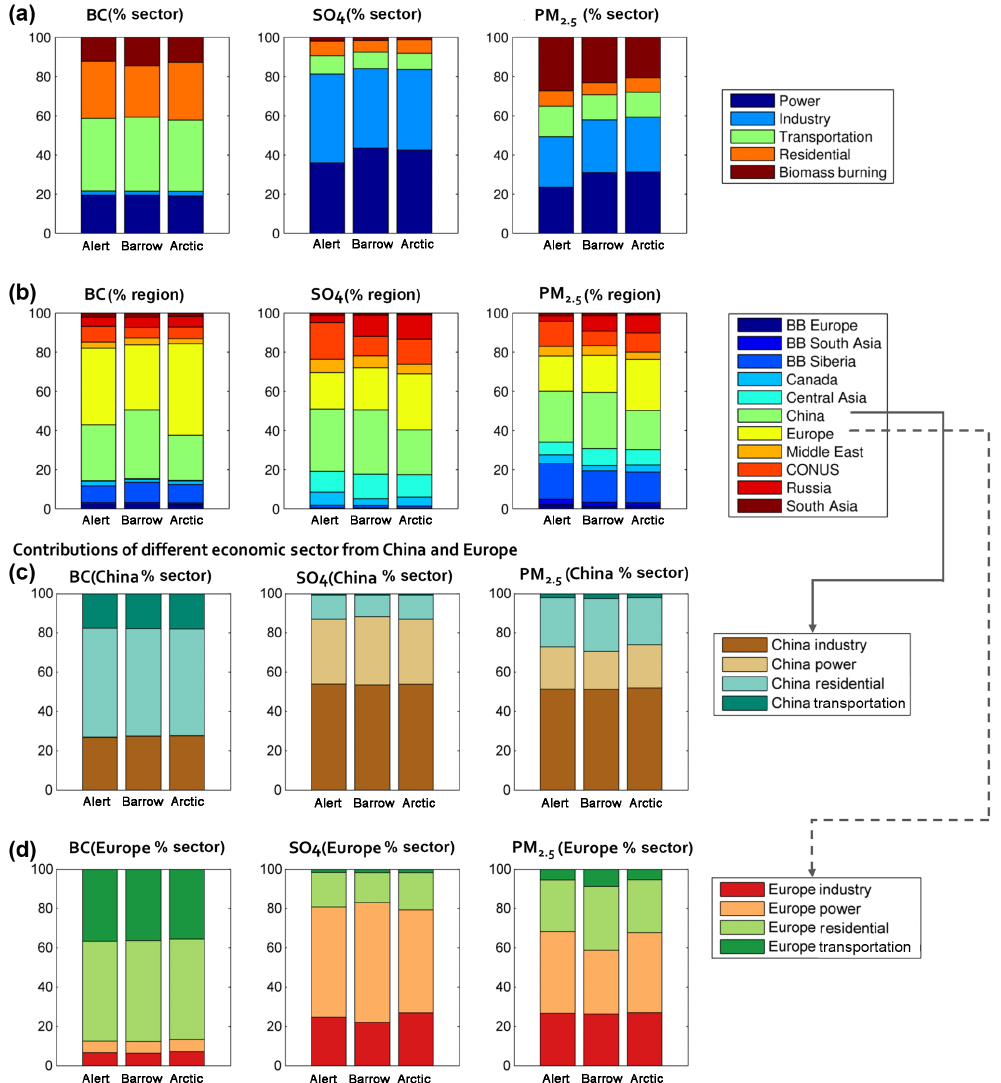
Figure 13. Summary of annual mean contributions to BC, sulfate (SO 4 ), and PM 2 . 5 by source sectors (a) and source regions (b) at Alert and Barrow, and over the Arctic regions. The bottom two rows of bar plots show the relative contributions of various economic sectors from either China (c) or Europe (d) to total Chinese or European contributions to Arctic BC, sulfate (SO 4 ), and PM 2 . 5 concentration. BB denotes biomass burning in this